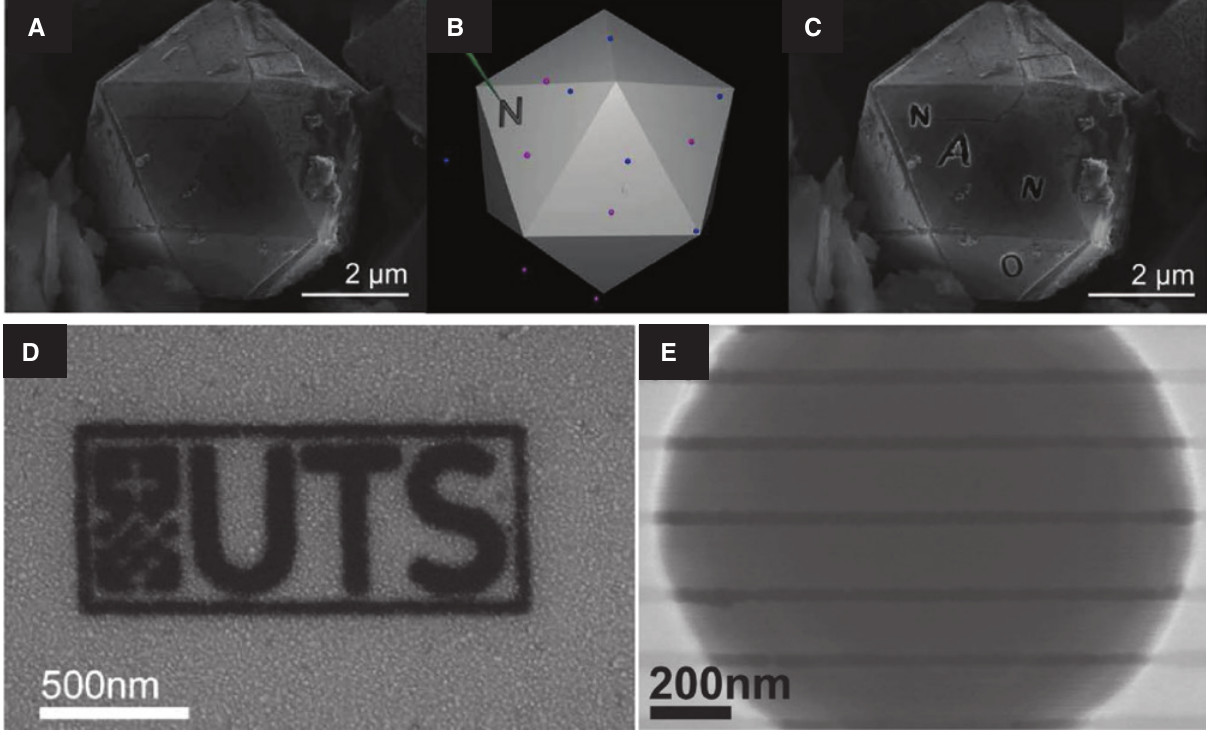
O mediated FEBIE: (A) SEM image of a single diamond micro-particle; (B) schematic illustration of direct write Figure 4: Direct writing by H 2 FEBIE process, each letter of NANO was written individually on three different 111 faces of a diamond; (C) SEM image of the microparticle shown in (A) after the letters NANO were patterned by FEBIE. [75]; (D) and (E) SEM images of symbol “UTS” and lines etched through a hex- agonal boron nitride flake, darker regions represent etched away areas [76].